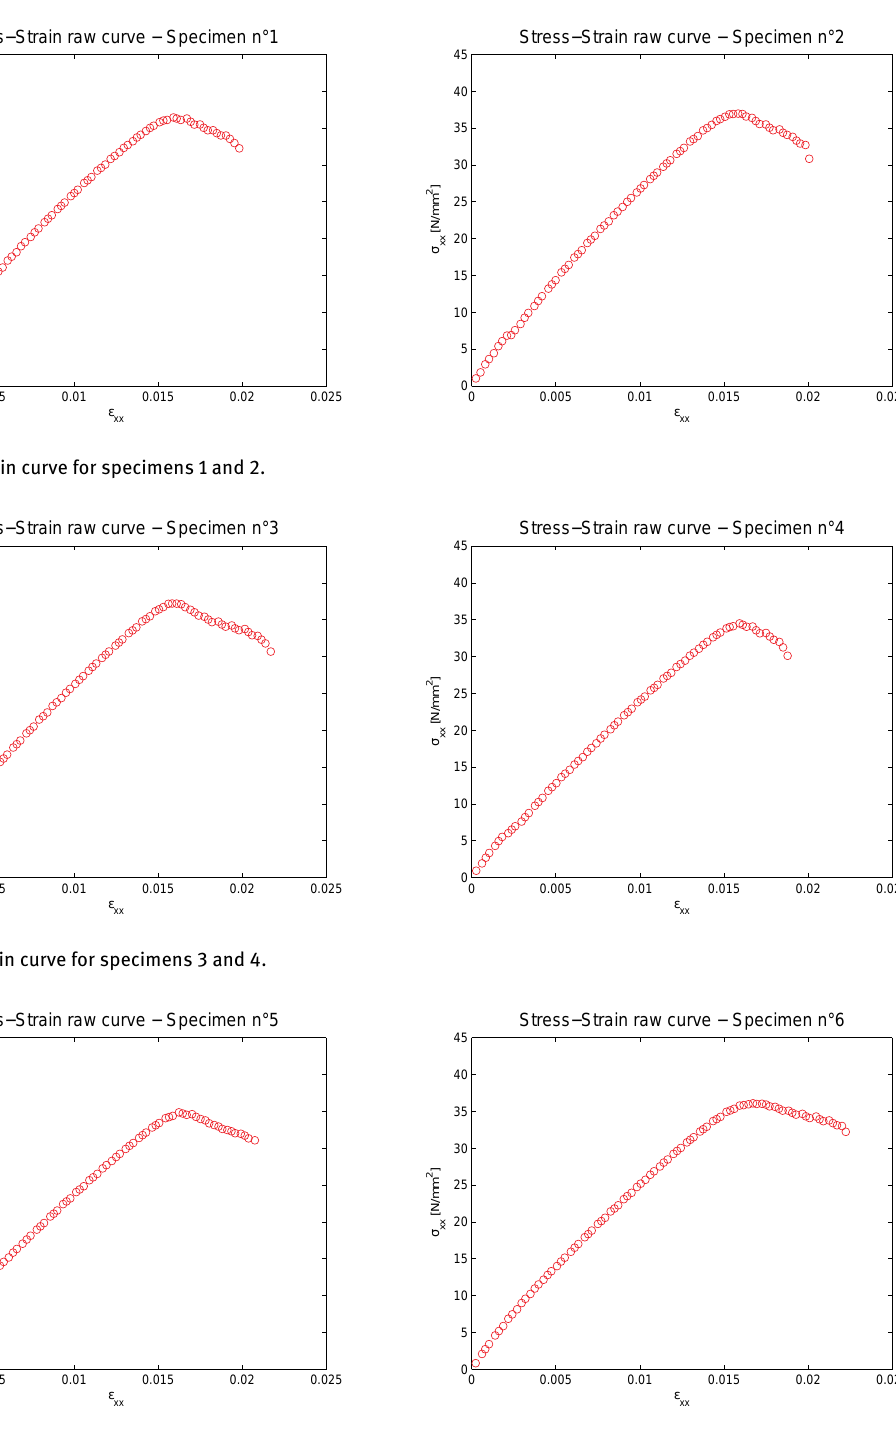
Figure 8: Raw stress-strain curve for specimens 5 and